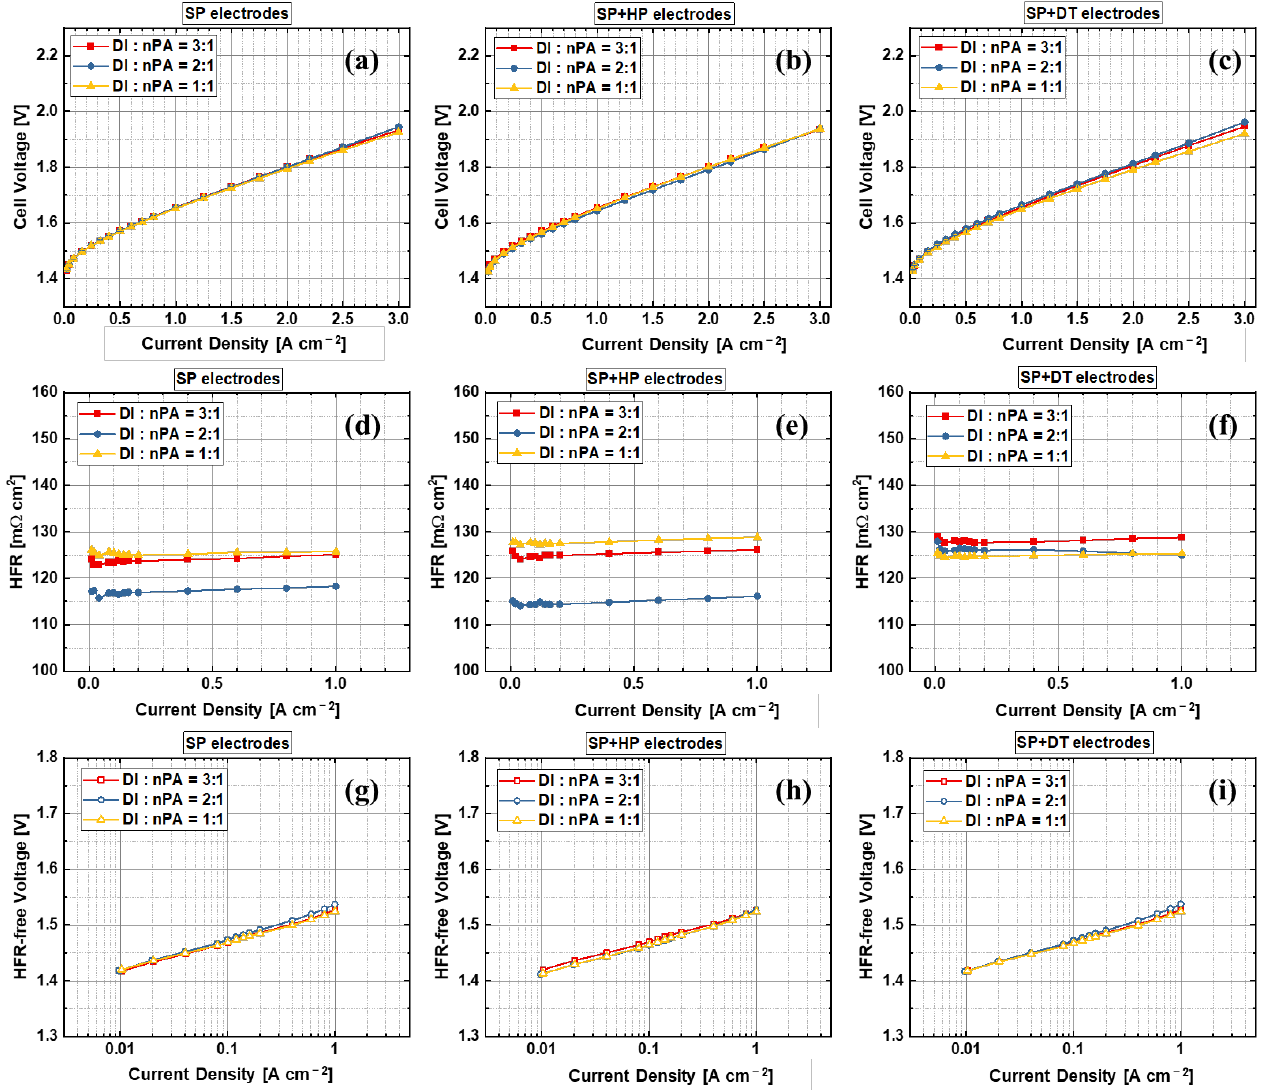
Figure 8. Effects of water to nPA ratio in anode electrode ink ( a – c ) performance, ( d – f ) HFR, and ( g – i ) Tafel slopes with different anode electrode fabrication methods ( a , d , g ) direct ultrasonic spray, ( b , e , h ) ultrasonic spray and hot press, and ( c , f , i ) ultrasonic spray and decal transfer.